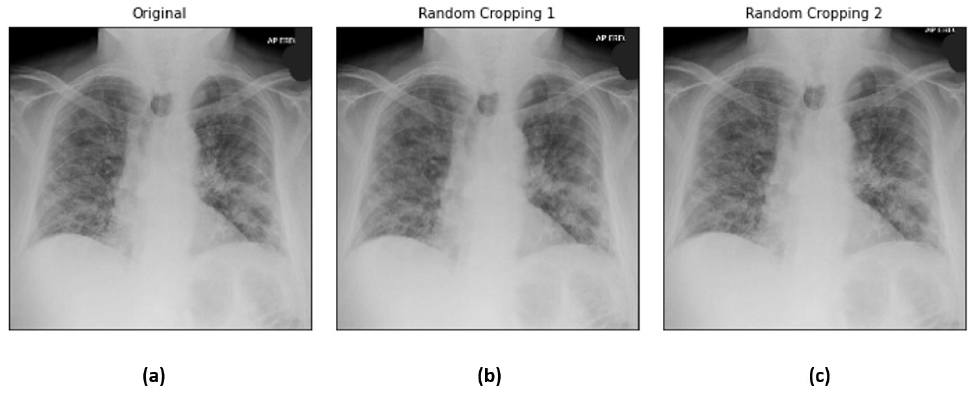
Figure 6. Sample chest X-ray images: ( a ) original, ( b ) random cropping ( r − 5, c − 5 ) and ( c ) random cropping ( r − 10, c − 10 )